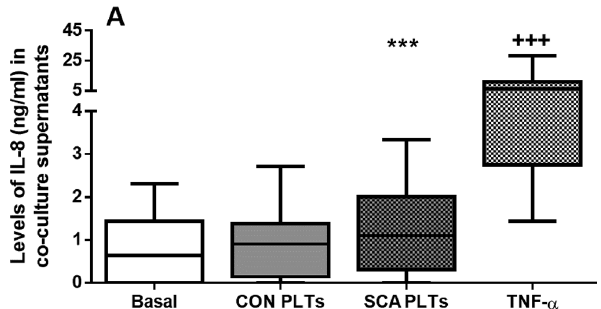
Figure 5. Release of IL-8 from co-cultures of HUVEC and PLTs. Levels of IL-8 (ng/ml) were quantified in supernatants of co-cultures of HUVEC (1 6 10 6 cells/well) (4 h in suspension, 37 u C, 5% CO 2 ) in direct contact with CON (n=27) or SCA PLTs (1 6 10 8 PLTs/well; n=44), (4 h, 37 u C, 5% CO 2 ); or following pre-incubation of HUVEC with TNF- a (10 ng/ml; N=24; 3 h, 37 u C, 5% CO 2 ). ***, P , 0.001, compared to basal (N=24); +++ , P , 0.001, compared to all